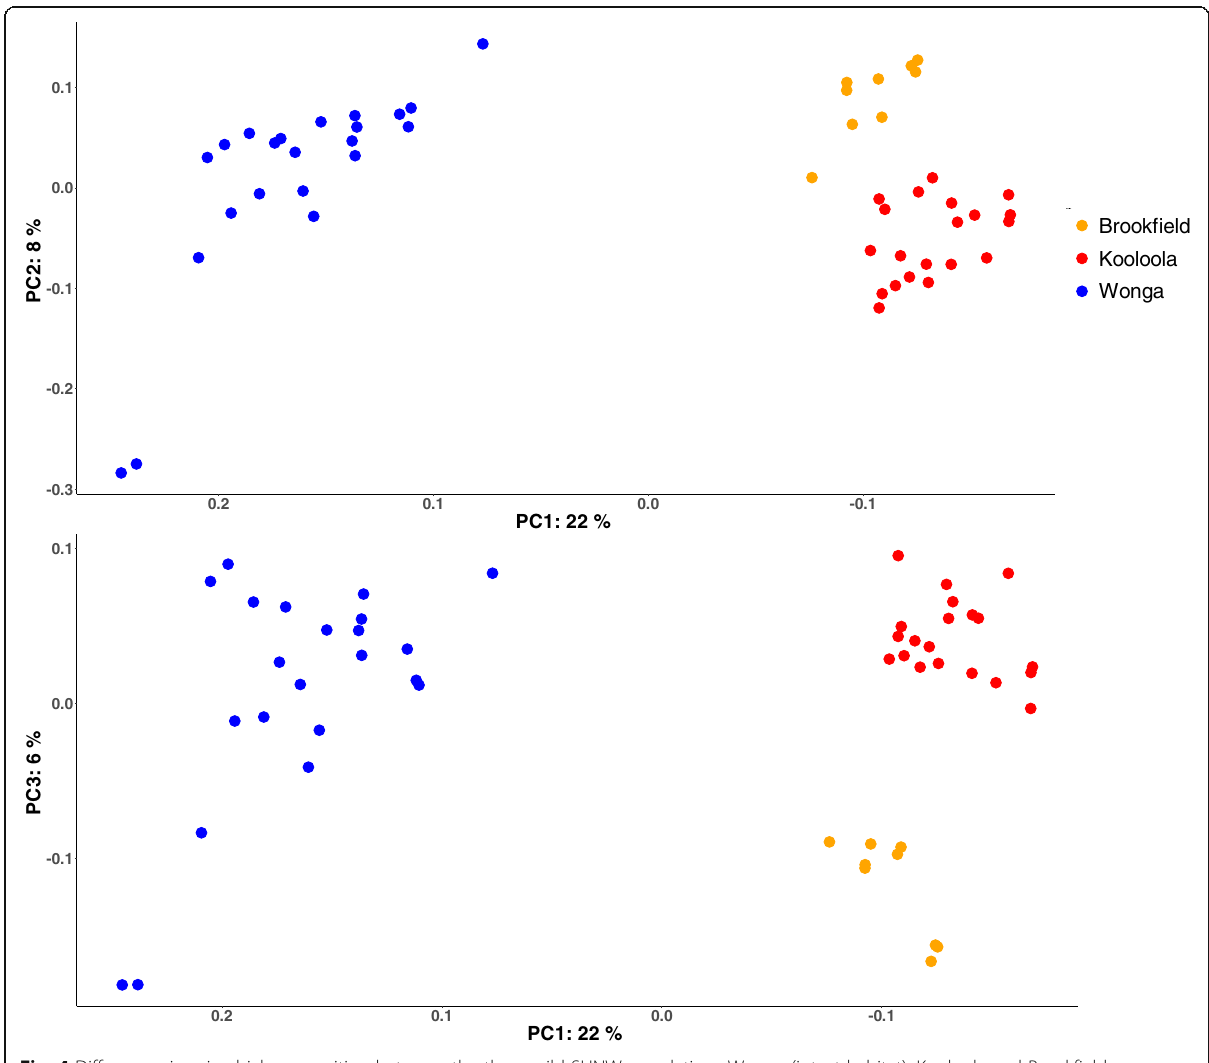
Fig. 4 Differences in microbial composition between the three wild SHNW populations Wonga (intact habitat), Kooloola and Brookfield (degraded habitat). PERMANOVA of microbial composition between populations is statistically significant. Principal coordinates analysis (PCOA) of unweighted UniFrac distances show separation of Wonga and Kooloola/Brookfield samples on PC1. PC2 and PC3 appear to separate Kooloola and Brookfield